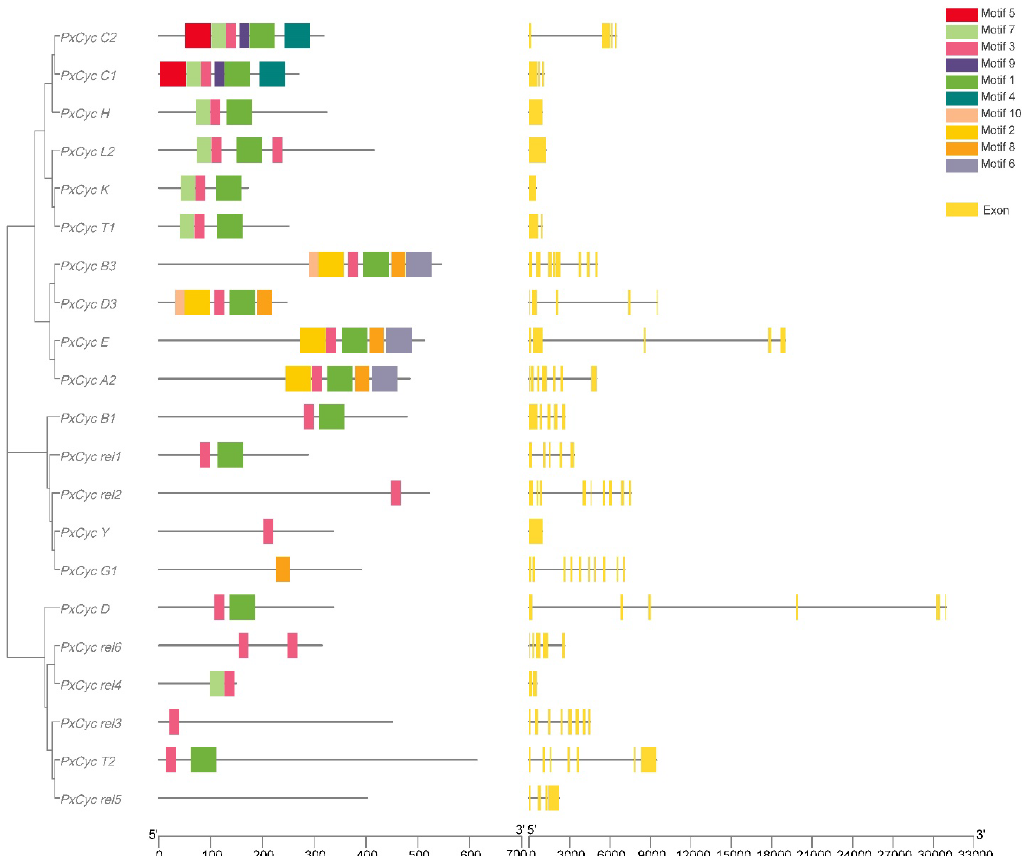
Figure 1. Conserved motif distribution patterns and gene structure (exons–introns distribution) of cyclin-like protein in P. xylostella . Commonly shared motifs among genes tend to cluster in the same groups, referring to their similar functions. Most cyclin-like genes are composed of one and five exons, and few genes are composed of the maximum number of exons (10).